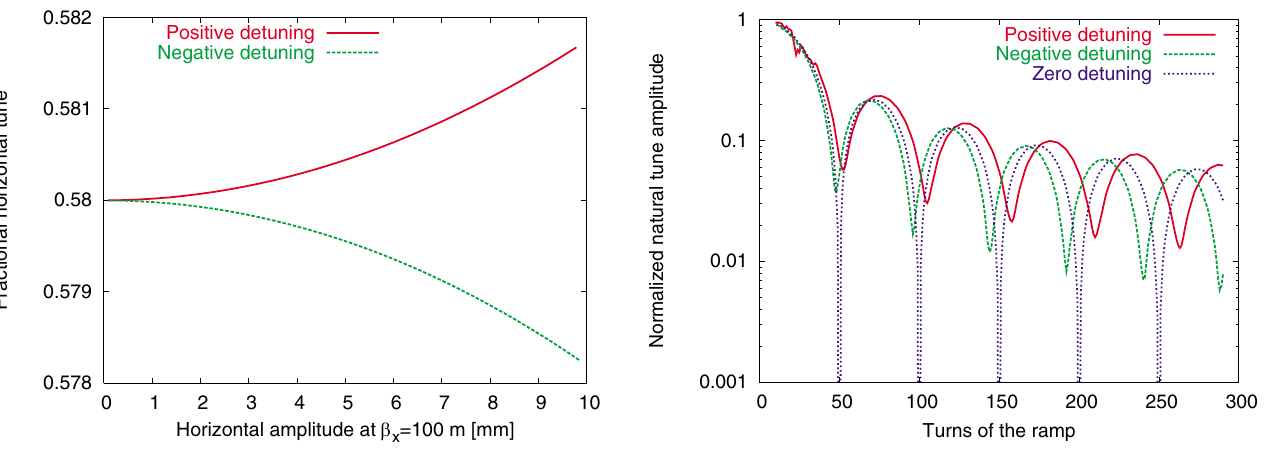
FIG. 2. (Color) Amplitude detunings used in the simulations.